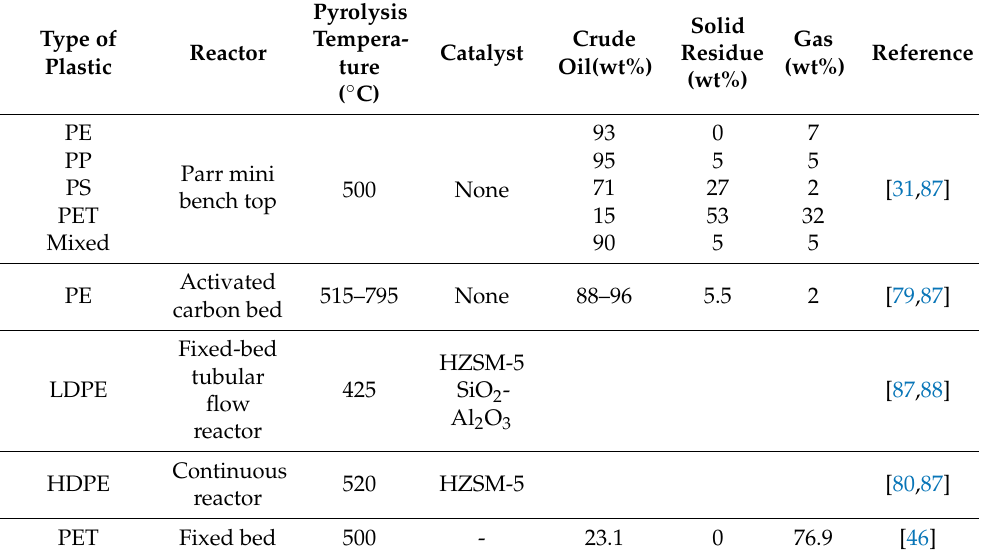
Table 4. Summary of studies on plastic waste using pyrolysis